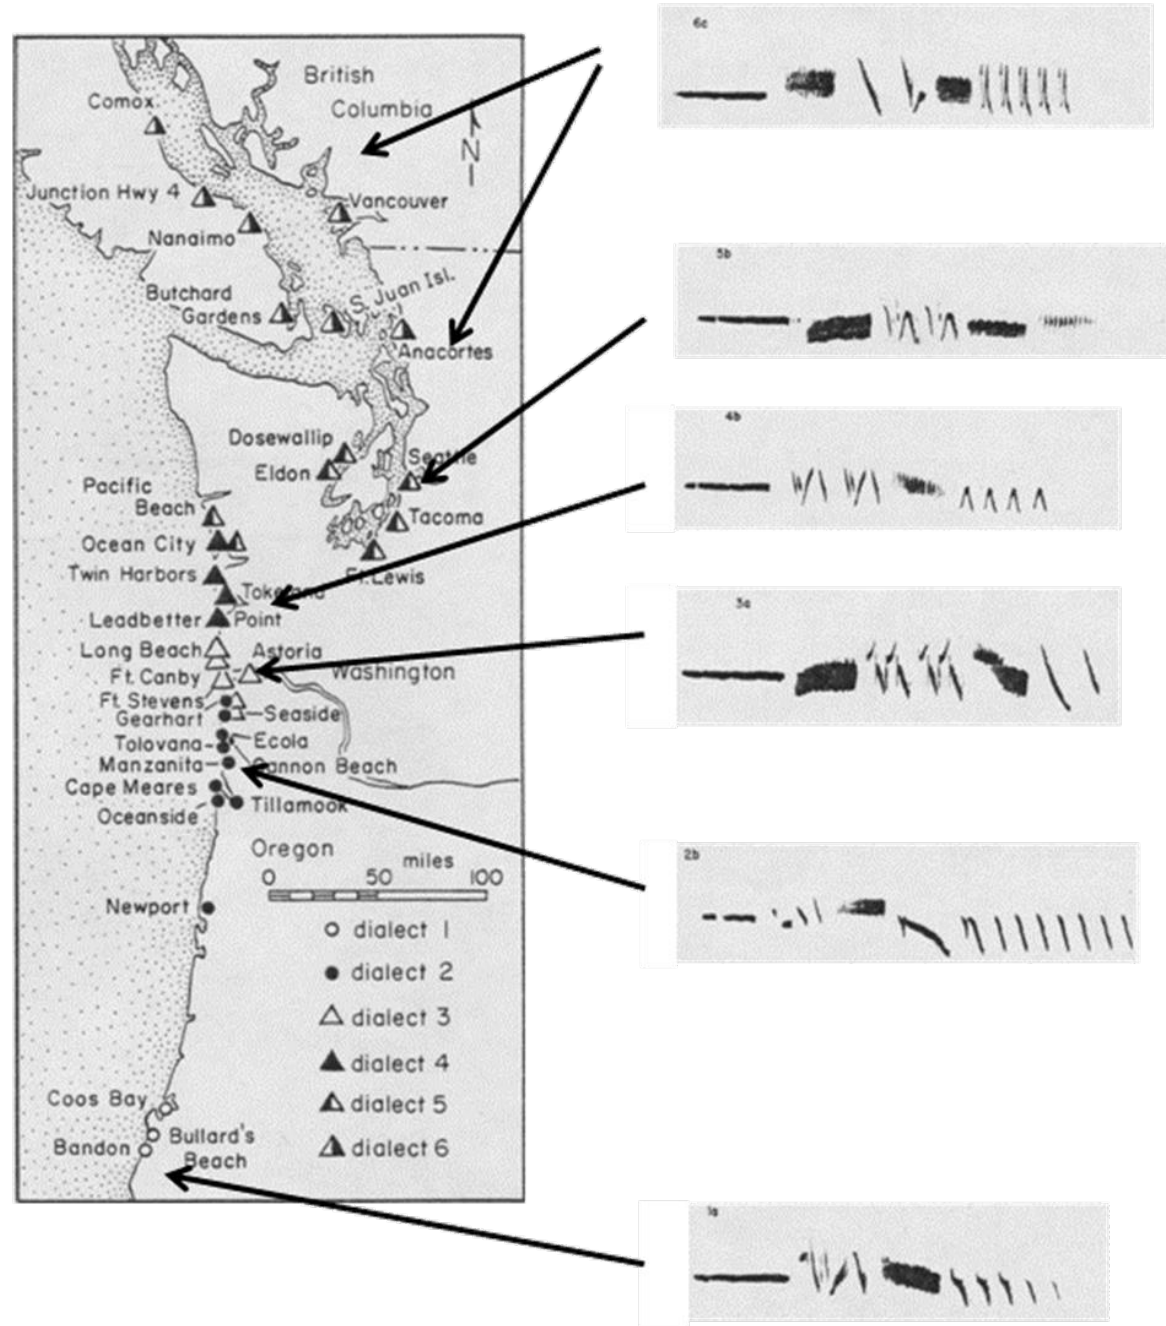
Figure 2. Dialect distribution in white-crowned sparrow along the west coast in North America (Baptista, 1977). We will adopt here Mundinger’s definition (1982): “a song dialect is a variant song tradition shared by members of a local population of birds, with a dialect boundary delineating it from other variant song traditions” . Animal dialectal boundaries are more generally sharp, but some “hybrid” forms at the boundaries are known to occur in some species. Munidnger’s definition implies that the shared vocal pattern results from “tradition” that is from social copying (i.e., learning from conspecifics) and hence eliminates the early descriptions of “dialects” in bees, now shown to be largely under genetic control and adapted to environmental conditions (Gould, 1982; Lindauer, 1977), but also questions the use of the